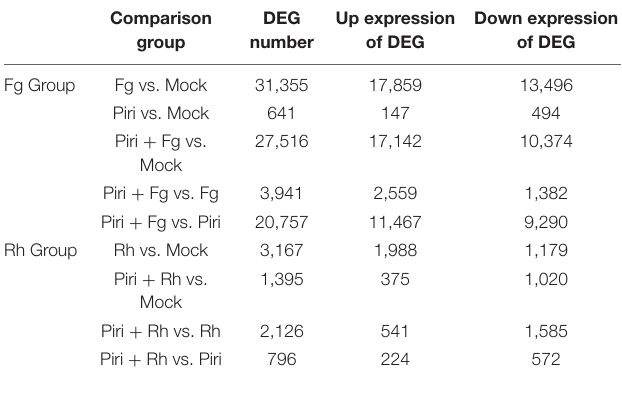
TABLE 2 | Differentially expressed genes (DEG) in the different comparison